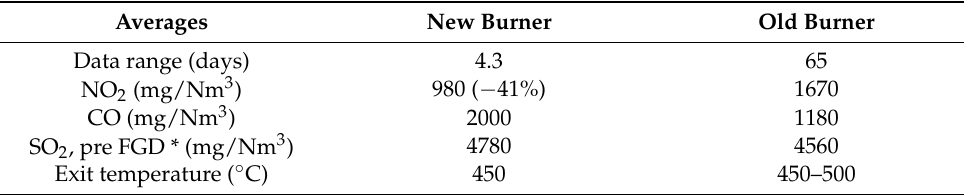
Table 5. Old vs. new